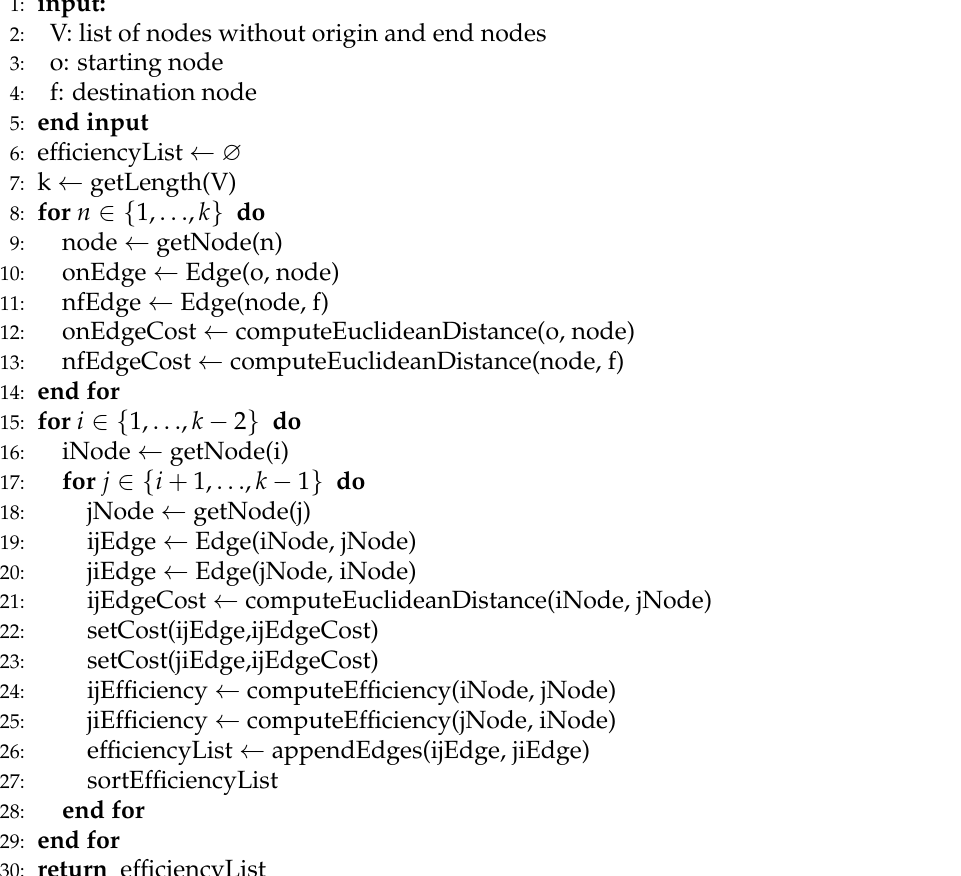
Algorithm 1 Computing the efficiency